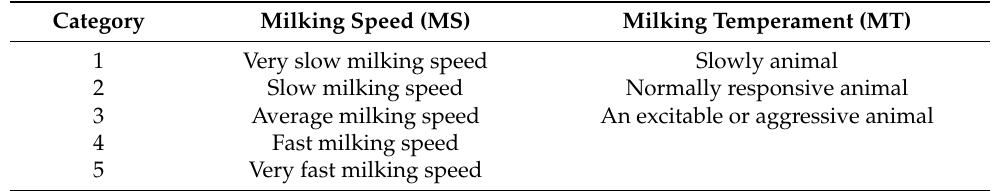
Table 1. Workability traits scale points.